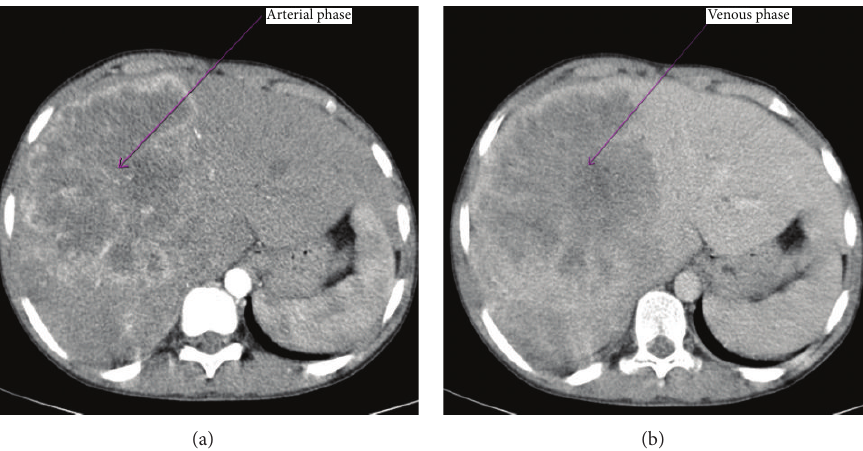
Figure 1: Ill-defined soft tissue density lesion of size 12 × 10cm in right lobe of liver which shows marked heterogeneous enhancement on arterial phase (a) and shows washout of the contrast in the venous phase (b).